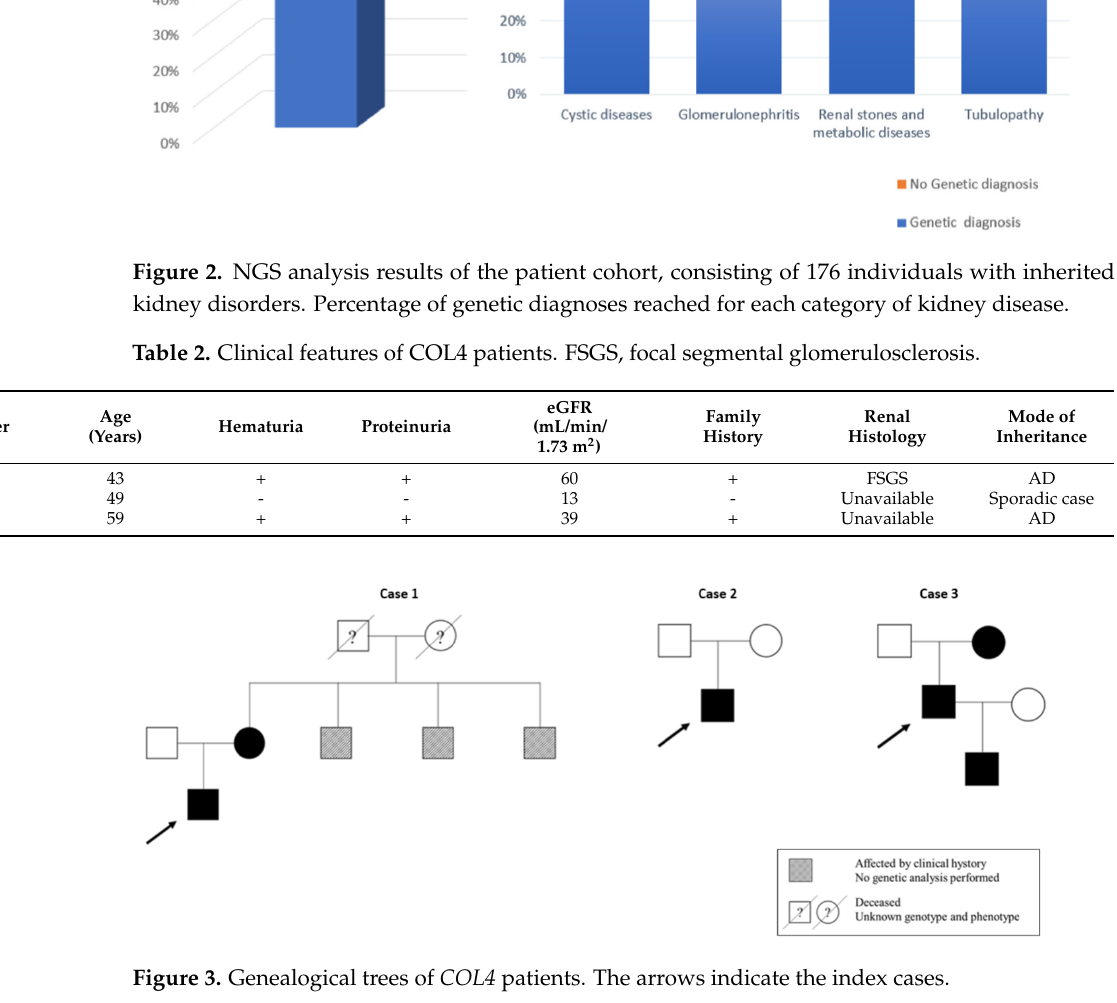
Figure 4. Case 1 kidney biopsy. Light microscopy and immunohistochemistry revealed a classic FSGS with IgM and C3 mesangial deposits, a picture shared with his mother; immunohistochemis- try revealed increased deposition of extracellular matrix. Case 2 was a 49-year-old man that referred to the hospital in emergency for epistaxis who had unremarkable personal and familial history of disease. He denied su ff ering from any signi fi cant morbidity; he was not under chronic medication and did not exhibit pre- vious medical reports. On admission, high blood pressure and advanced renal dysfunc- tion (estimated GFR of 13 mL/min/1.73 m 2 ) were revealed. Sensorineural deafness was referred. Renal ultrasound showed a decreased size of the right kidney, with parenchymal calci fi cations and fetal lobulation bilaterally. The abdomen computed tomography (CT)